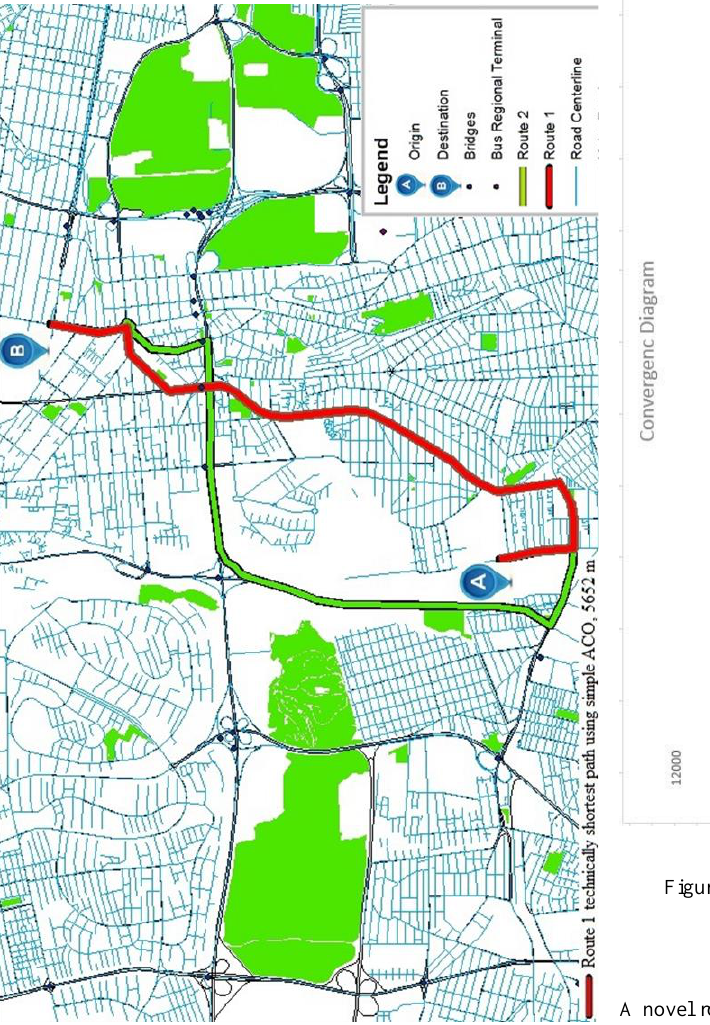
Figure 8. Optimum path between point A and B